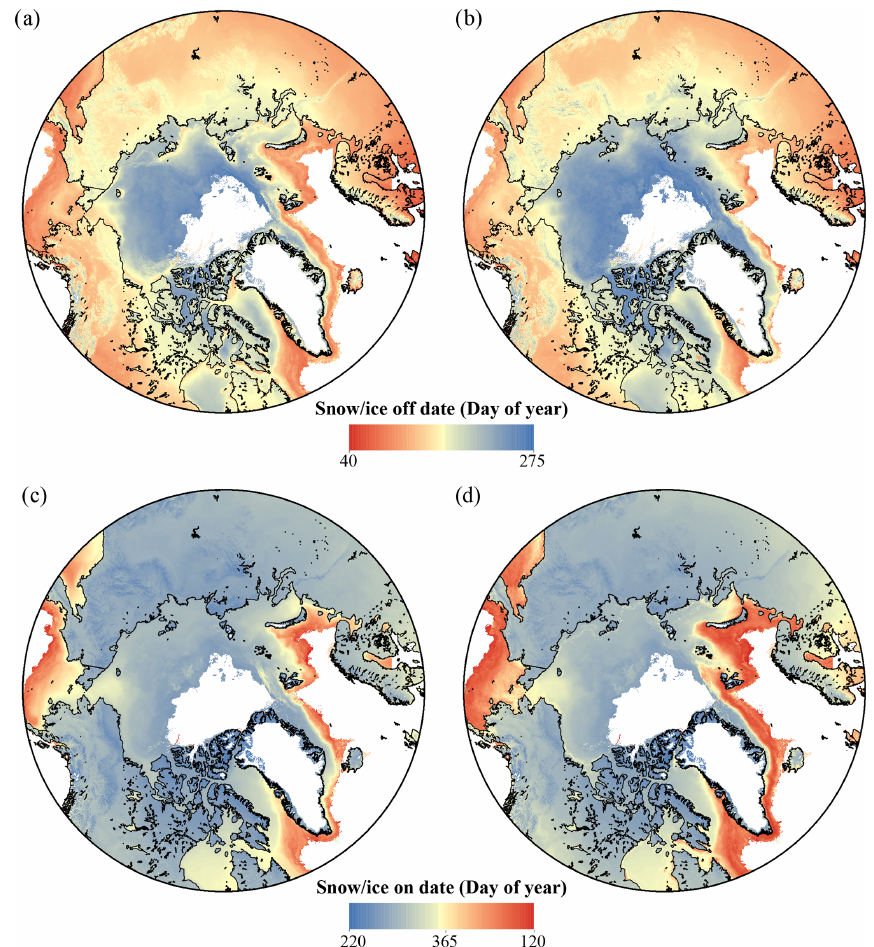
Figure 3. Mean 4km IMS (2004–2019) (a) sea ice first open water (FOW S ), first snow-off (first_s OFF ), and lake ice first open water (FOW L ); (b) sea ice water clear of ice (WCI S ), final snow-off (final_s OFF ), and lake ice water clear of ice (WCI L ); (c) sea ice freeze onset (FO S ), first snow-on (first_s ON ), and lake ice freeze onset (FO L ); and (d) sea ice continuous ice cover (CIC S ), final snow-on (final_s ON ), and lake ice continuous ice cover (CIC L ). White regions indicate where either no snow/ice forms or snow/ice remains all year in 14 or more years of the